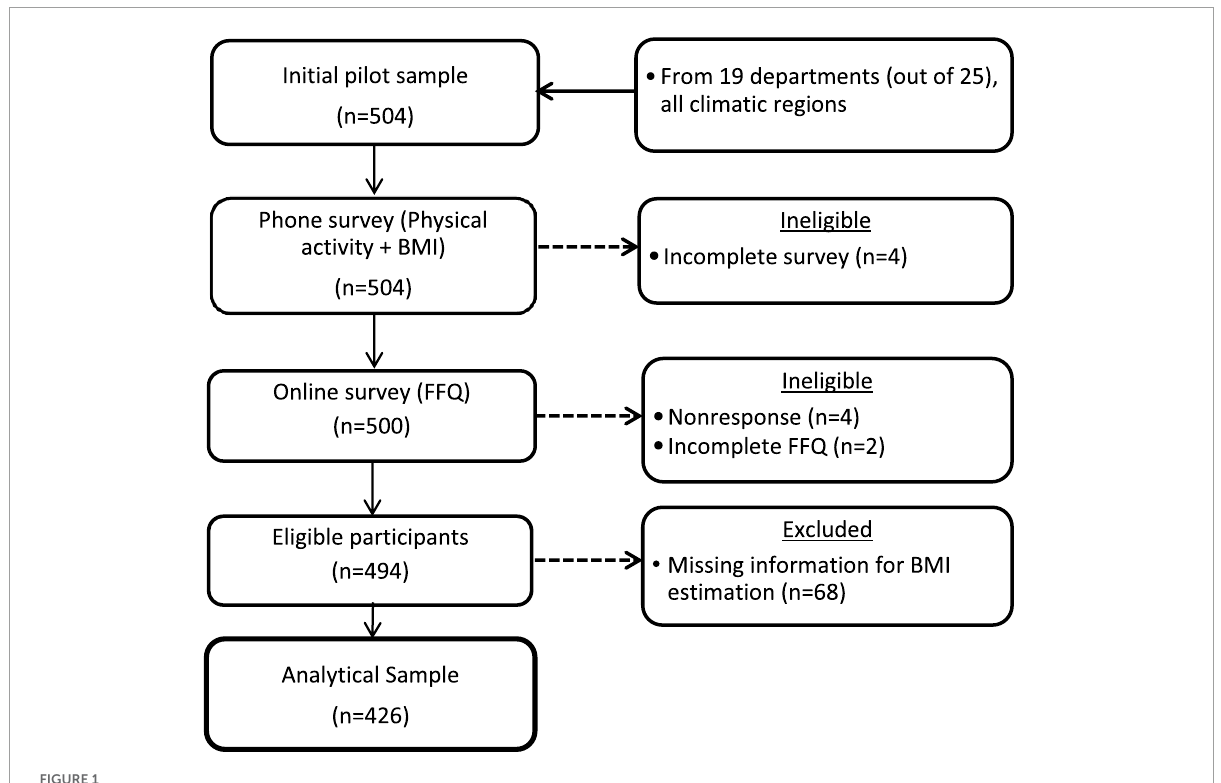
FIGURE1 Flow chart showing the selection criteria for the identification of the analytical sample.